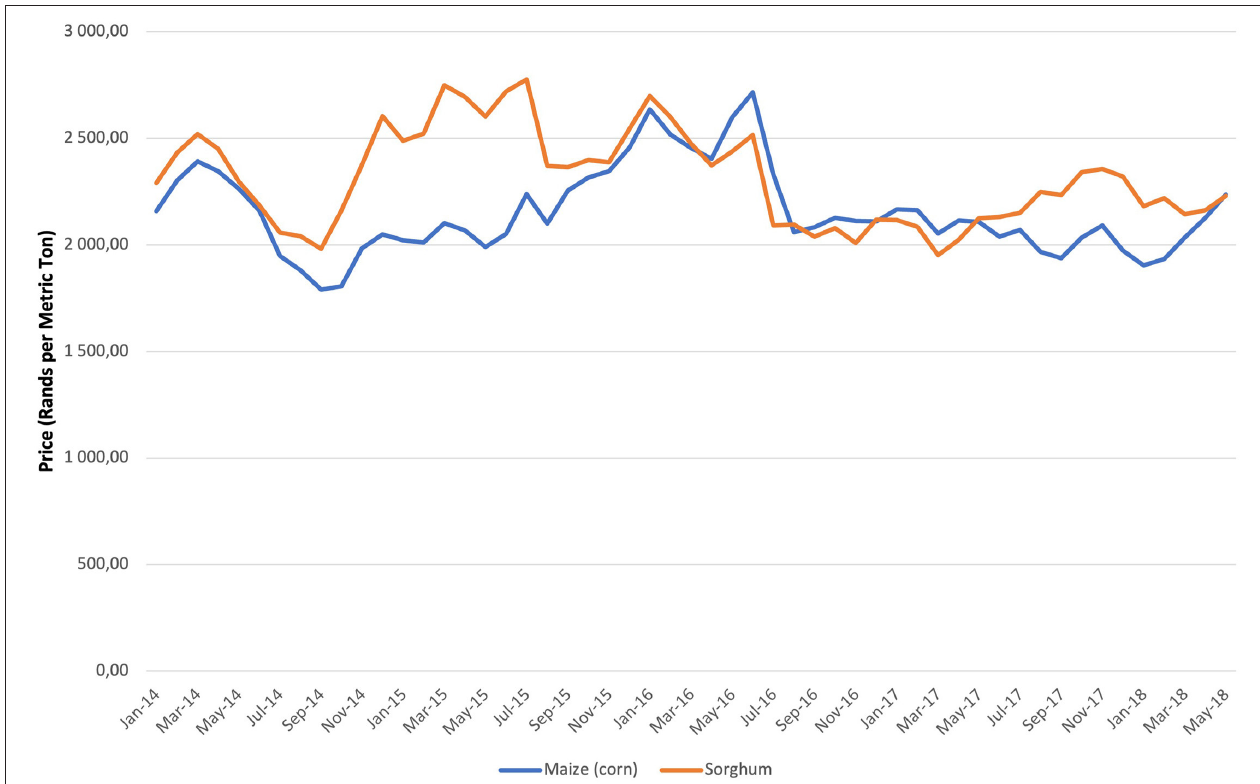
FIGURE 4 | Price of maize and sorghum January 2014 to May 2018 in ZAR per ton. Source: